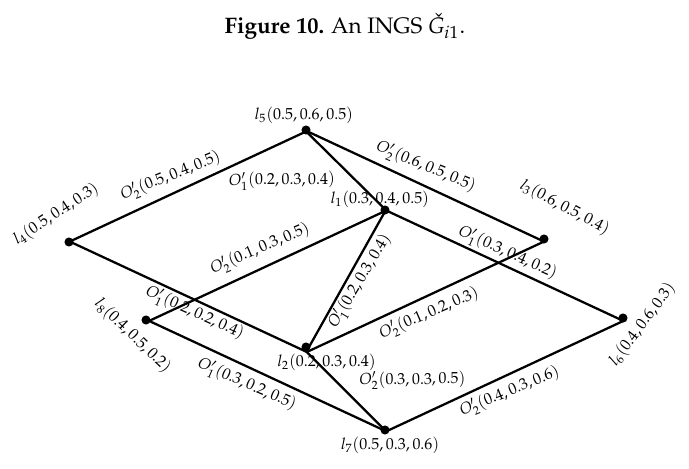
Figure 11. An INGS ˇ G i 2